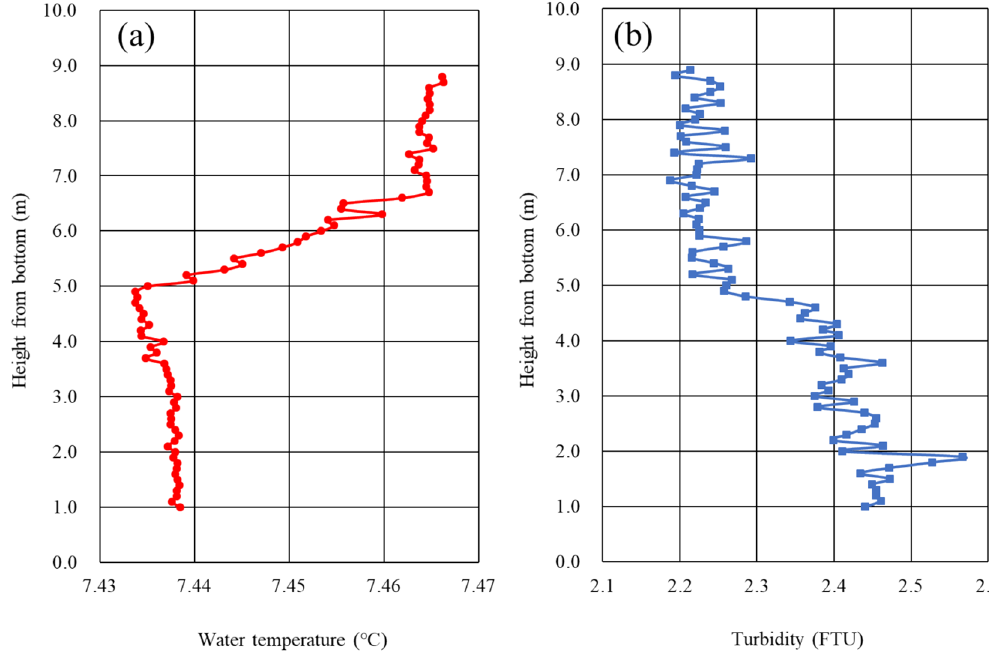
Figure 5. ( a ) Water temperature profile and ( b ) turbidity profile in the benthic boundary layer near the deepest area in the North Basin of Lake Biwa measured on 28 September 2011. Warmer temperature and higher turbidity coexist in the layer from 1 to 5 m above the bottom, which may maintain density stability.